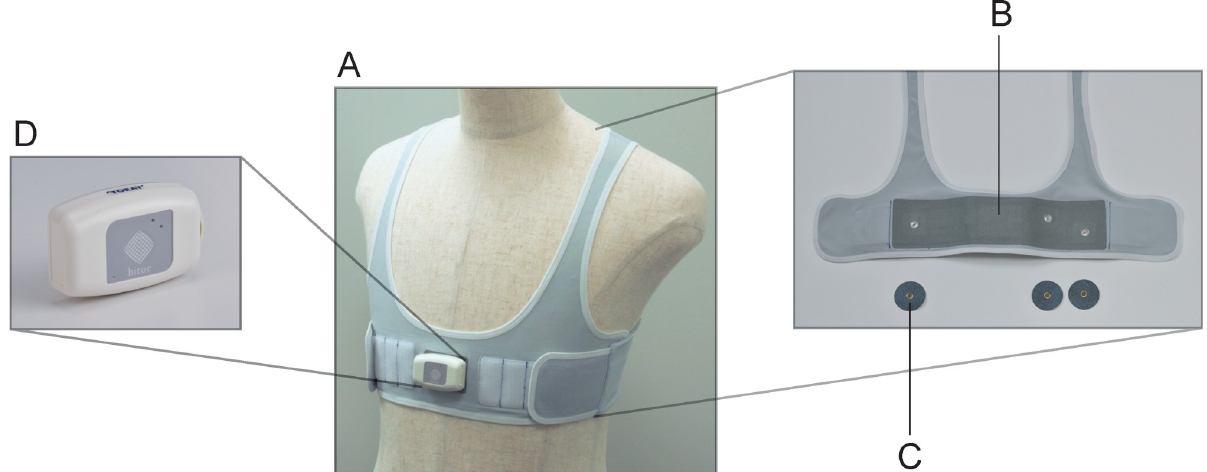
Fig 2. Garment ECG system with hitoe 1 dry electrode. A, The hitoe 1 dry electrode is sewn into a stretchy fabric used for sportswear, for a wearable ECG unit that can be washed. The unit can be put on and taken off easily by patients, facilitating near-continuous monitoring. B, The hitoe Medical Leads II: Lead wires are pre-installed on the wearable device and conduct the signal detected by the electrodes to the electrocardiograph. The pressure adjustment function allows the wearer to obtain the proper position and adherence, enabling comfortable extended monitoring. C, The hitoe Medical Electrode II: Electrodes are made of an electrically conductive textile material called hitoe. The polyester nanofiber fabric is coated with a dielectric polymer to prevent rash even with prolonged use. D, The hitoe ECG Recorder EV-301: The recorder is a compact lightweight Holter electrocardiograph, capable of continuous recording for up to 2 weeks without recharging. ECG,